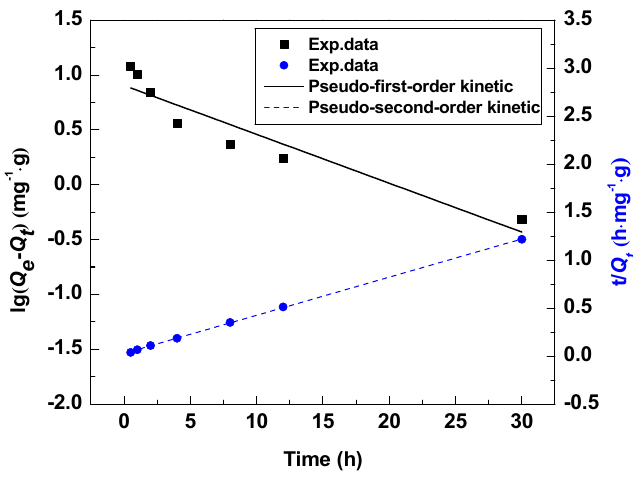
Figure 10. Pseudo-first-order and pseudo-second-order kinetic curves Li + adsorption by HMO at 18 °C. Table 4. Dynamic parameters of lithium adsorption.